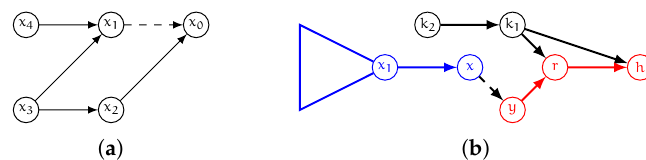
Figure 3. ( a ): assume all arcs in this example have unitary weight and the vertex ordering is { x 0 , x 1 , ... , x 4 } . Both x 4 and x 3 are in F L G ( x 1 , x 0 ) since the hub vertex for pairs x 4 , x 0 and x 3 , x 0 , in the labeling L induced by the above ordering, is vertex x 0 . However, if arc ( x 1 , x 0 ) is removed then d G ( x 4 , x 0 ) changes while d G ( x 3 , x 0 ) does not, since x 3 has two shortest paths of the same weight to x 0 . ( b ): In the toy graph G shown here the only shortest path from x to h passes through arc ( x , y ) . Therefore, if ( x , y ) undergoes a decremental update, we have that x , x 1 , and all vertices that are connected to x 1 , are in the forward cover graph (in blue). Symmetrically, r and h are in the backward cover graph (in red) while k 1 and k 2 are in neither of the two cover